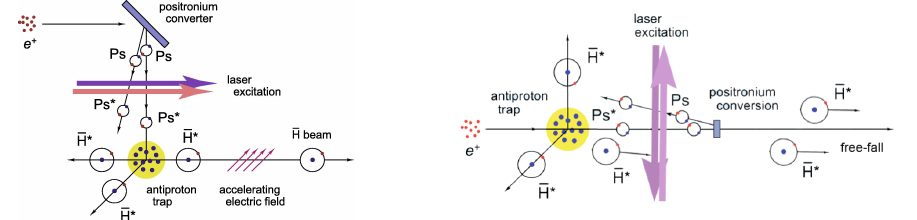
Figure 1: Schematics of antihydrogen production in AEgIS. Left: orthogonal scheme used for AEgIS Phase 1. Right: collinear scheme used for AEgIS Phase